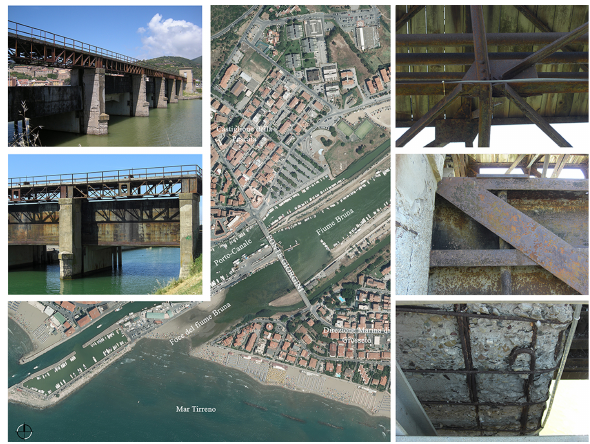
Figure 1. The Giorgini